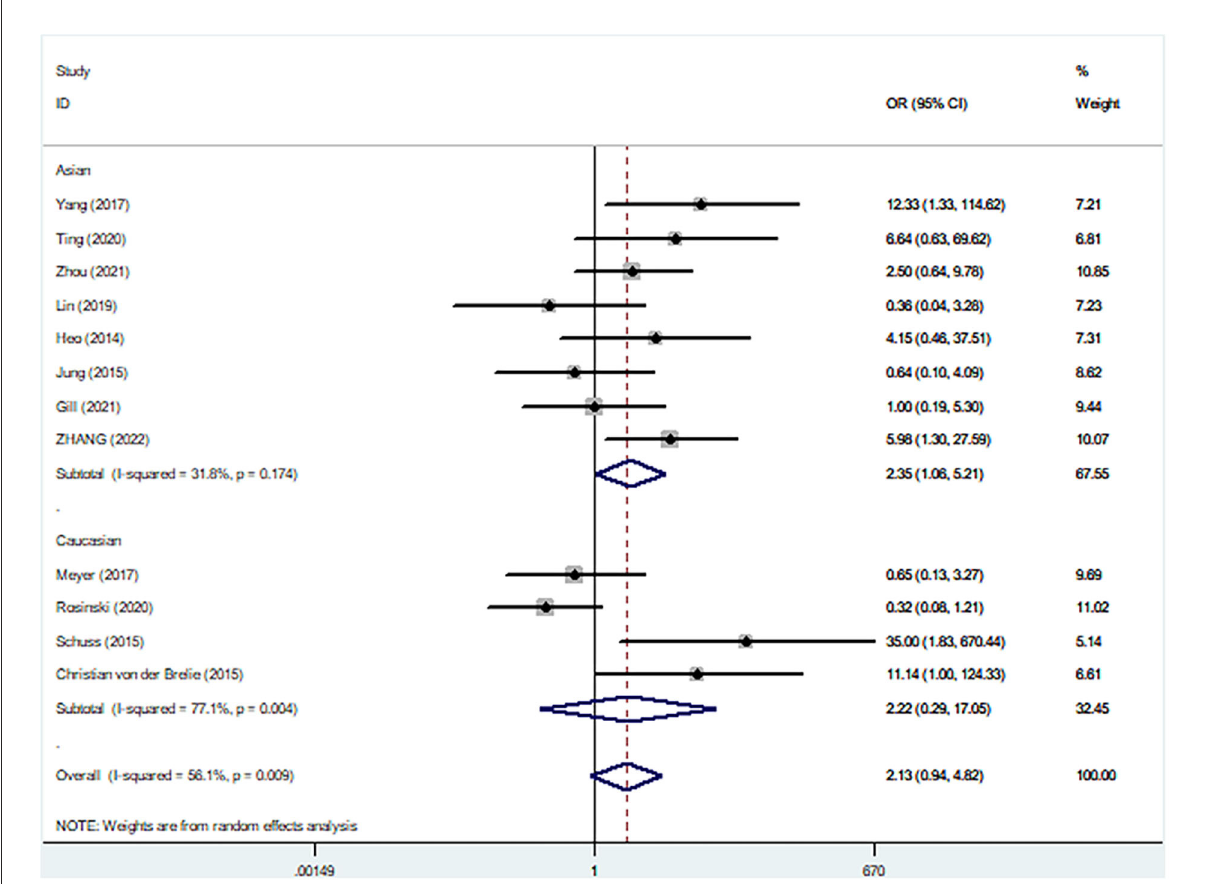
FIGURE7 Comparisons of postoperative infection complications between staged and simultaneous cranioplasty and ventriculoperitoneal